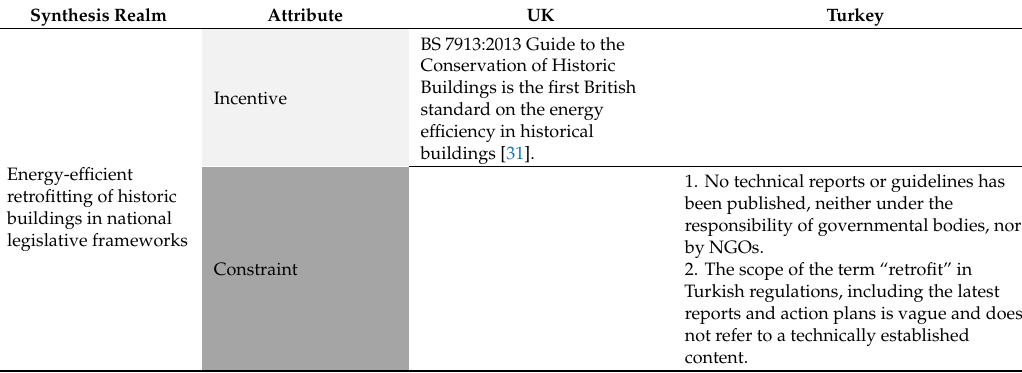
Table 1. Comparative synthesis on energy retrofitting of historic buildings in the UK and